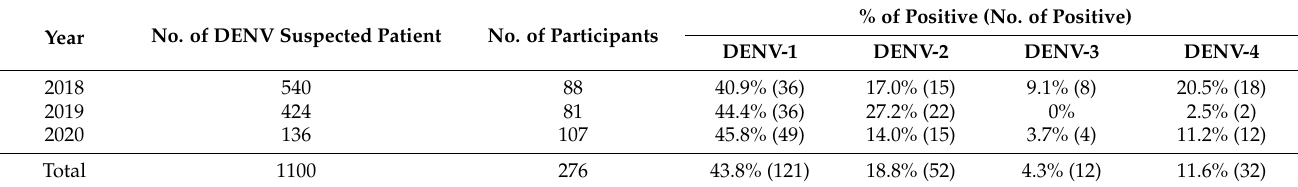
Table 1. The percentage of DENV serotype positive samples among participants from the Hospital for Tropical Diseases, Bangkok, Thailand, during 2018–2020.